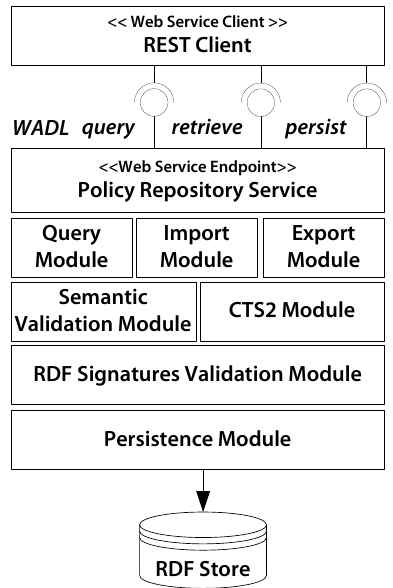
Figure 4. System architecture of the Policy Management